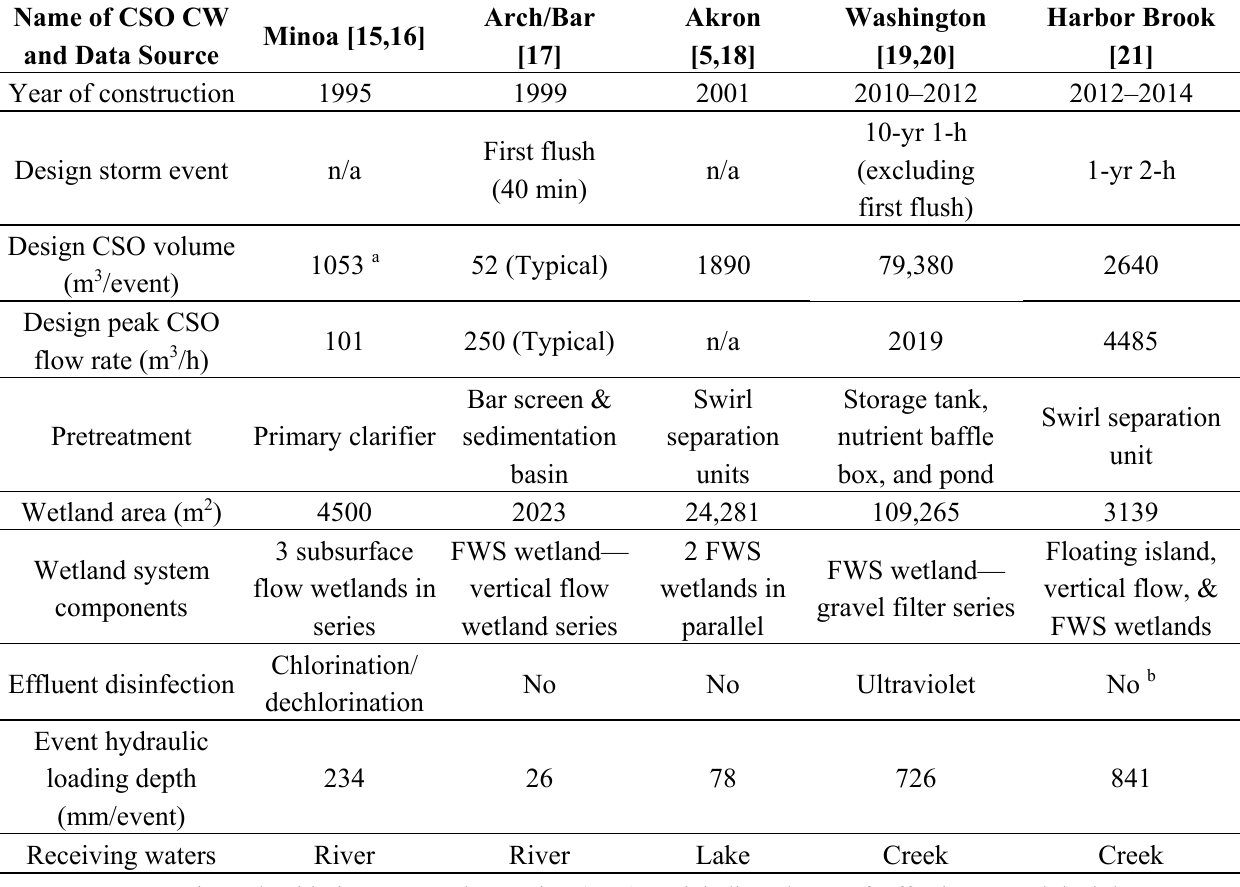
Table 2. Wetland treatment systems receiving combined sewer overflow in the